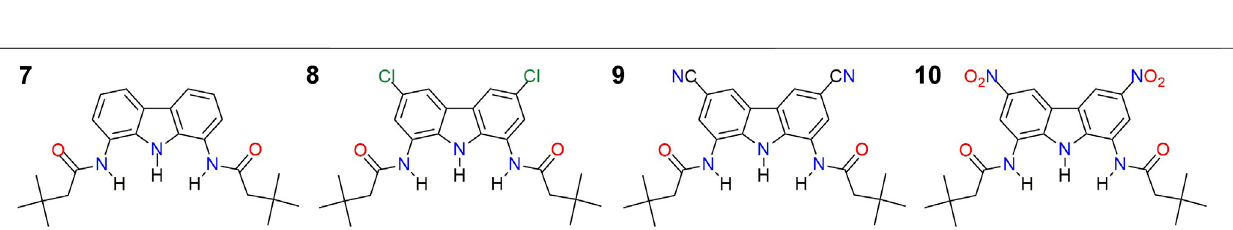
FIGURE 1 | Examples of chloride transporters from literature: 1 - ref. (Valkenier et al., 2014); 2 - ref. (Dias et al., 2018b); 3 - ref. (Valkenier et al., 2015); 4 - ref. (Dias et al., 2018a), 5 - ref(Ba ̨ k et al., 2018); and 6 - ref. (Picci et al., 2020).